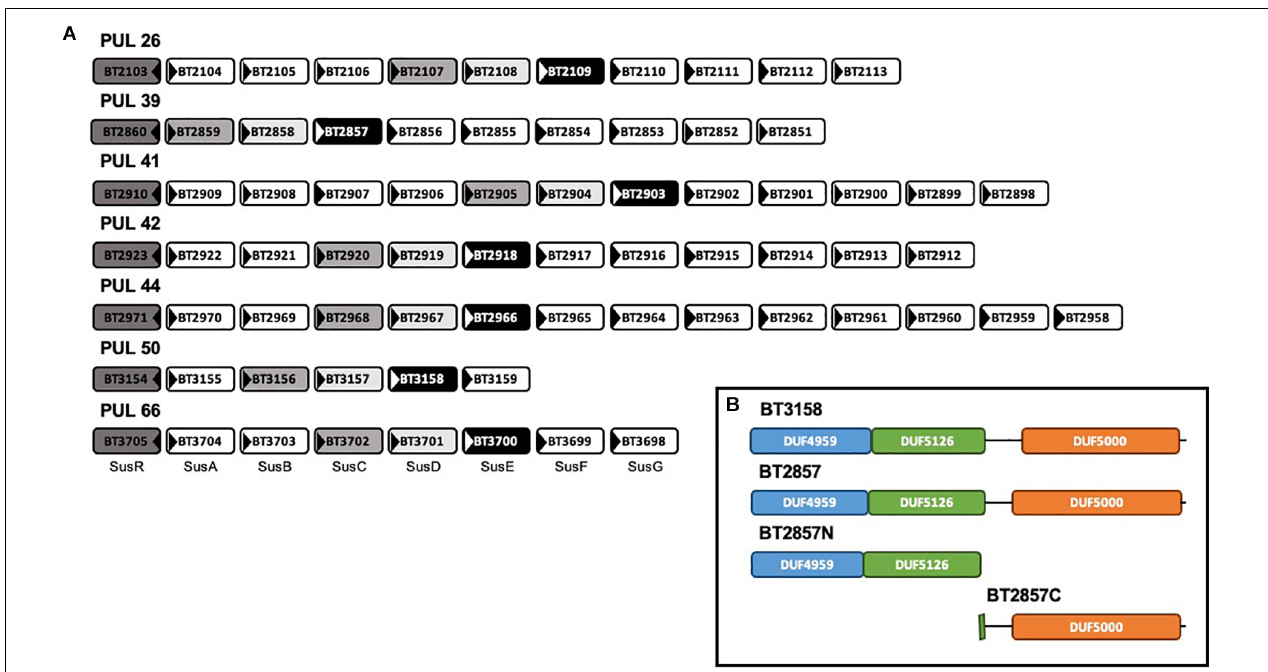
FIGURE 1 | Genomic organization of six SusE-like B. thetaiotaomicron polysaccharide utilization loci and the model Sus polysaccharide utilization loci (PUL66) and domain architecture of SusE-like target BT2857. (A) Located at the beginning of each Sus and Sus-like loci is the gene encoding a regulatory protein, illustrated by each dark gray box. Medium gray and light gray boxes indicate SusC- and SusD(-like) proteins, respectively. Black boxes indicate homologous SusE-like proteins. White boxes represent miscellaneous members of each PUL (Martens et al., 2009a). This architecture organization highlighted PULs 26, 39, 41, 42, 44, and 50 to have these unique features within the B. thetaiotaomicron ATCC 29148 genome. To our knowledge, none of these PULs have had any activity attributed. (B) Inset–outer membrane-targeting signal peptides covering the first 19–20 amino acids were truncated from the expressed constructs. The first amino acid in each DUF4959 was found to be cysteine suggesting that SusE-like proteins, like their model counterpart, are anchored to the membrane via an attached lipid (Tuson et al.,